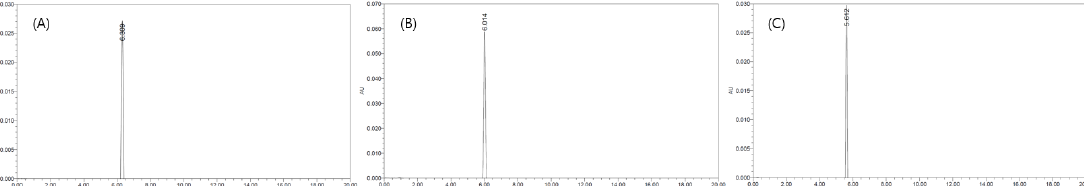
Figure 2. HPLC chromatograms of ethoxyquin in according to column varieties. ( A ) 20 °C, ( B ) 30 °C, ( C ) 40 °C.